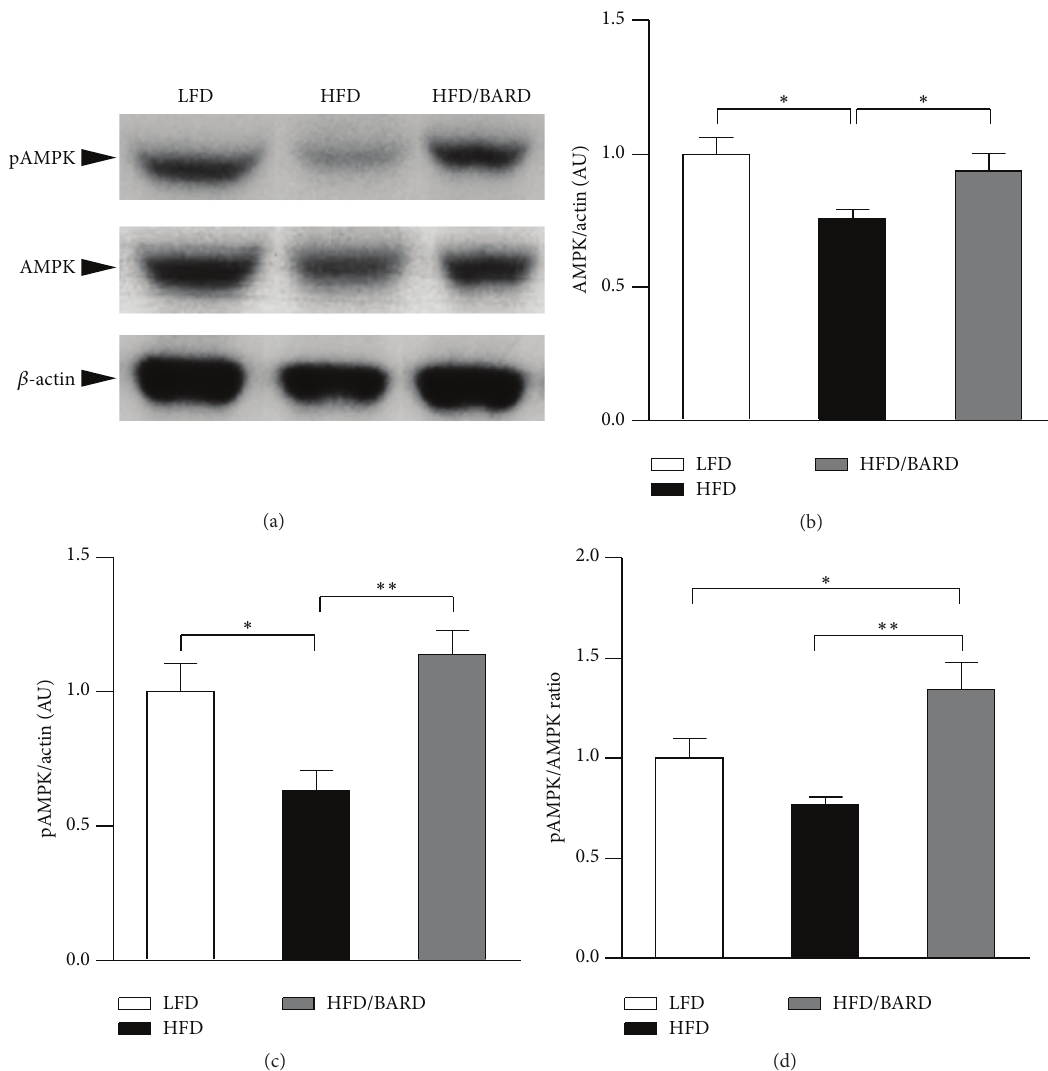
Figure 6: Effect of bardoxolone methyl (BARD) on expression of AMPK protein and its activity in mesenteric adipose tissue of mice fed low-fat diet (LFD), high-fat diet (HFD), and high-fat diet supplemented with BARD (HFD/BARD). (a) Representative blots. (b) Protein level of AMPK. (c) Protein level of phosphorylated AMPK. (d) pAMPK/AMPK ratio. All data are expressed as mean ± SEM. ∗ 𝑝 < 0.05 ; ∗∗ 𝑝 < 0.01 . AMPK: AMP-activated protein kinase; pAMPK: phosphorylated AMPK; AU: arbitrary